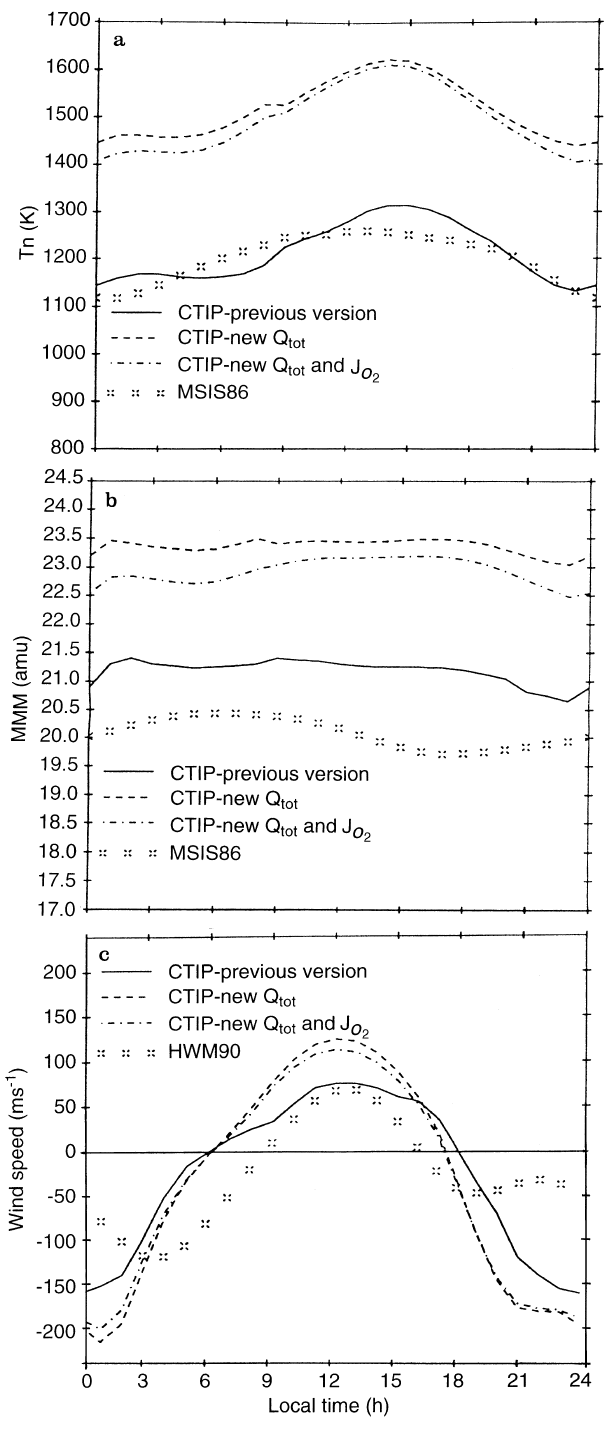
Fig. 3a–c . The effects of a new calculation of the solar heating and O 2 photodissociation rate on a T n ; b mmm and c V x (positive polewards) over Argentine Islands at 300 km, for December solstice conditions. The solid line refers to CTIP before any changes had been